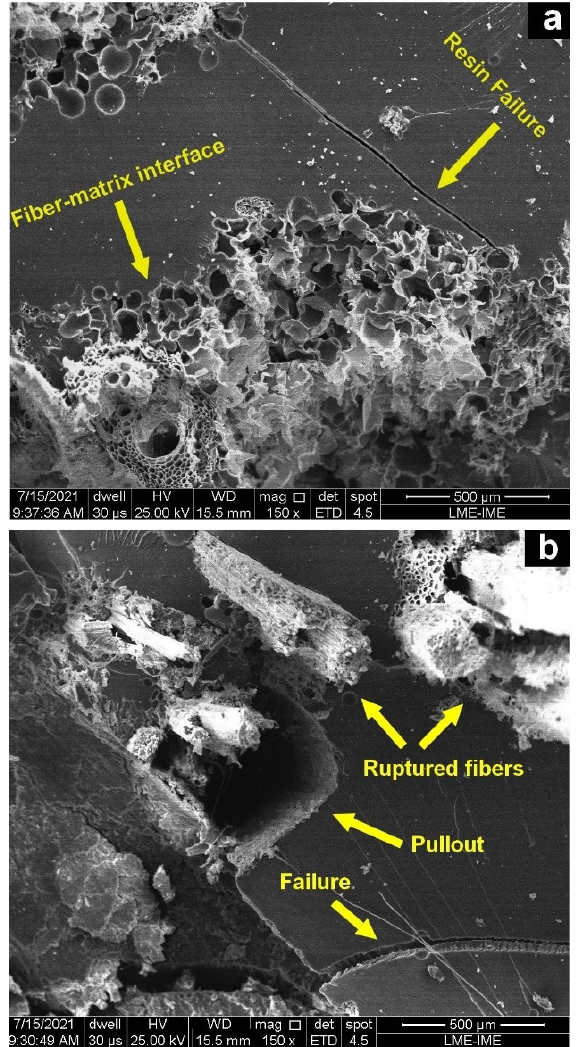
Figure 5. SEM images of composites reinforced with 30 vol% of caranan ( a ) fractured surfaces fibers ( b ) fiber pullout.